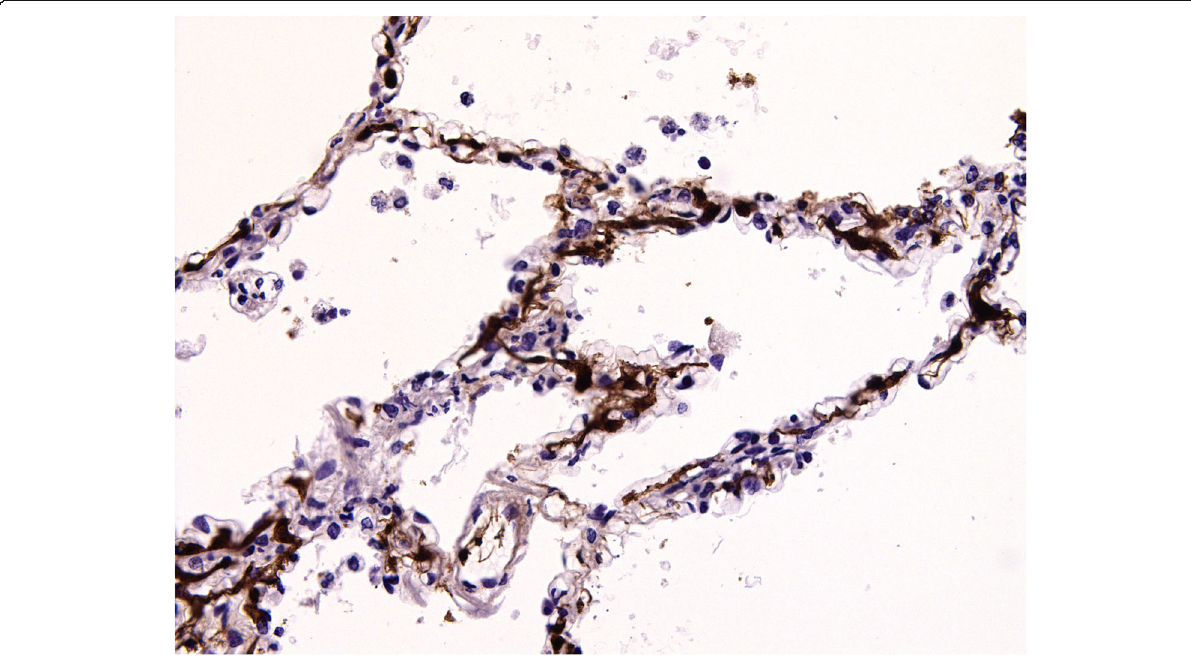
Fig. 7 COVID-19 lung with microthombi casting the capillaries of the alveoli (Fibrin stain, original magnification × 200)